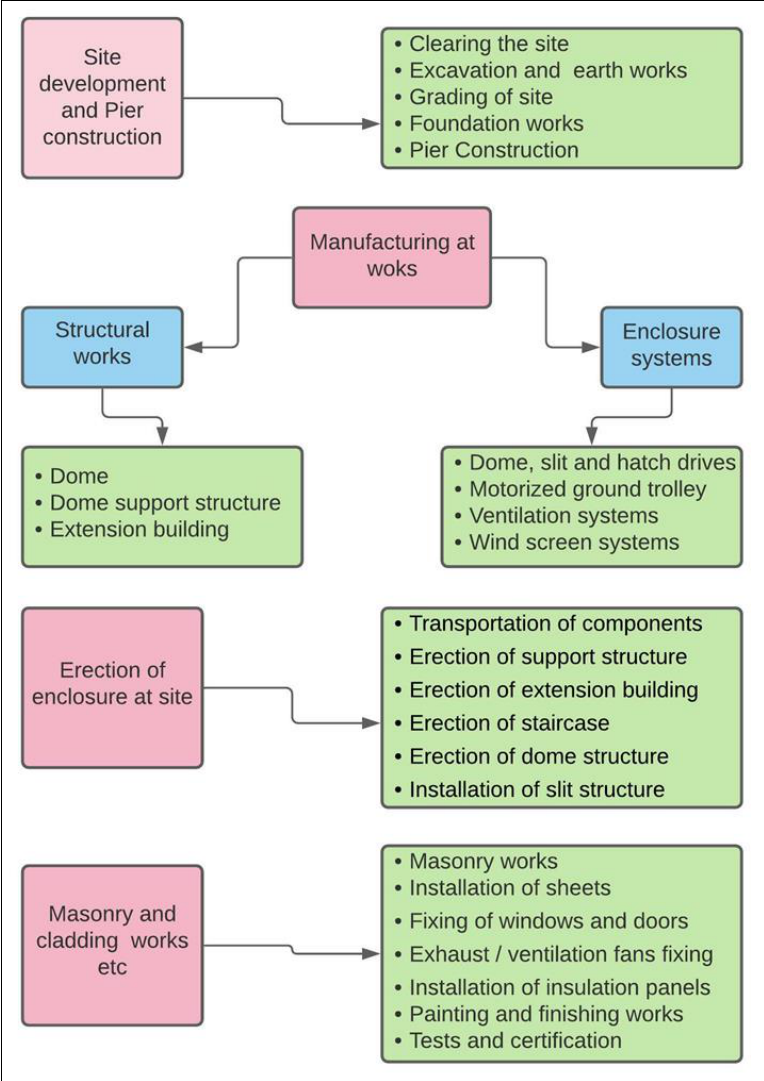
Figure 2. Four stages in construction methodology for 3.6 m telescope